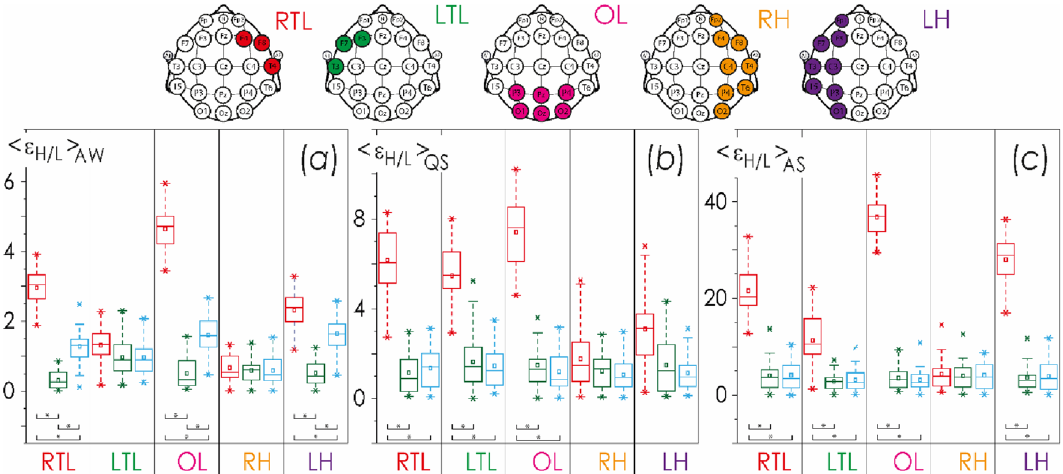
Figure 5. Distributions of the mean values of the integral energy ratios of the high frequency range to the low frequency range, (cid:31) ε H / L (cid:30) AW,AS,QS , for each brain region under consideration. These means are calculated for the physiological states of AW ( a ), QS ( b ) and AS ( c ). Acronyms for spatial zones are given under each diagram in accordance with Table 2. Red color indicates estimates for group I, GA34–37 10d . Green and blue colors code the estimates for the first and second monitoring events (GA38–41 8h and GA38–41 10d , respectively) in group II. The localization of EEG channels on the scalp for each hemisphere is shown above. The diagrams depict the following statistical characteristics of numerical indicators: the first and the third quartiles (25–75%, inside the box), the median and the mean (transverse line and point inside the box, respectively), 1.5 interquartile ranges (shown by whiskers), and outliers represented by asterisks. At the bottom, underlining with asterisks highlights the pairs of values meeting the Mann–Whitney test with p <